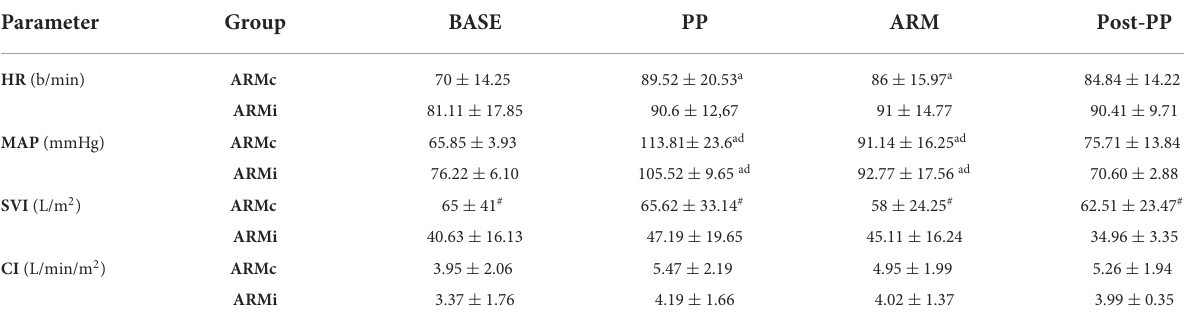
TABLE 3 Mean ± SD of the hemodynamic parameters evaluated in 20 dogs mechanically ventilated, undergoing laparoscopic surgery. Parameter